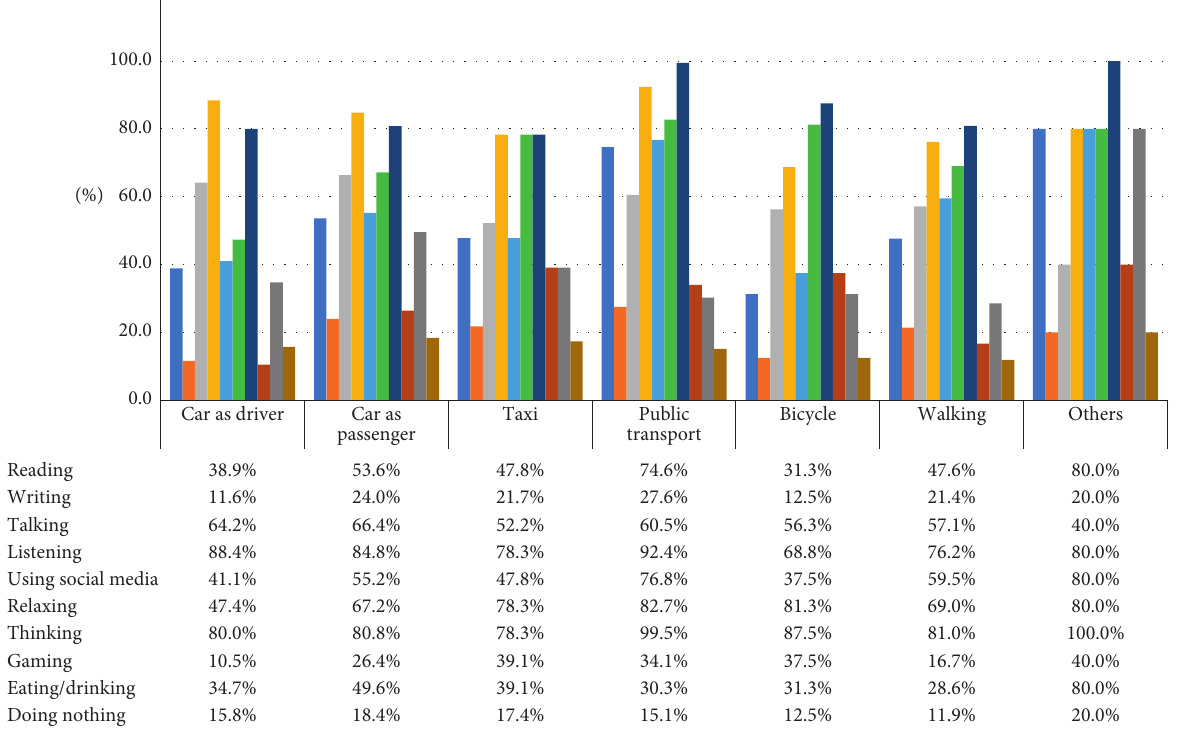
Figure 4: The percentage of each onboard activity that a transport mode user